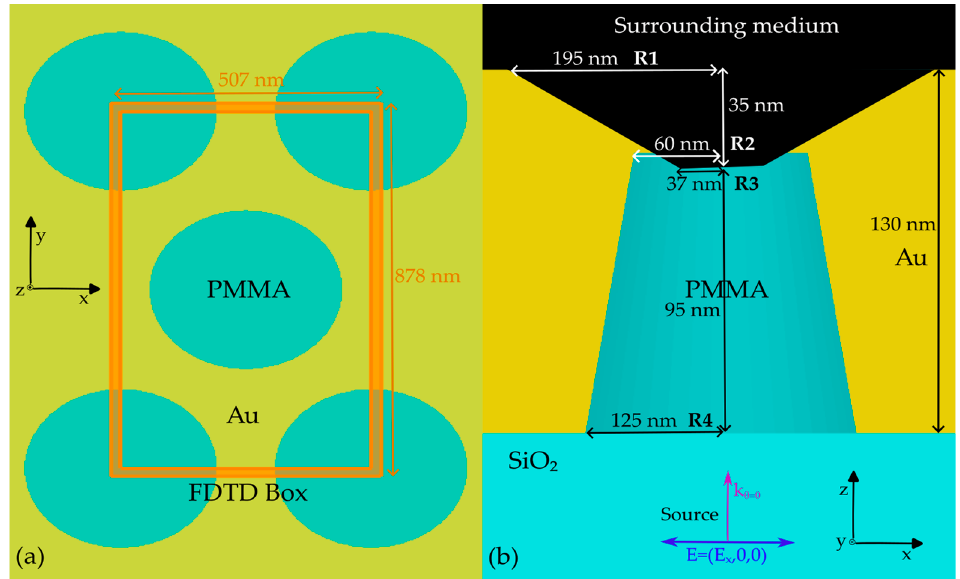
Figure 1. Top ( a ) and side ( b ) views of the FDTD-optimized structural model. The geometrical parameters are displayed together with their dimensions.